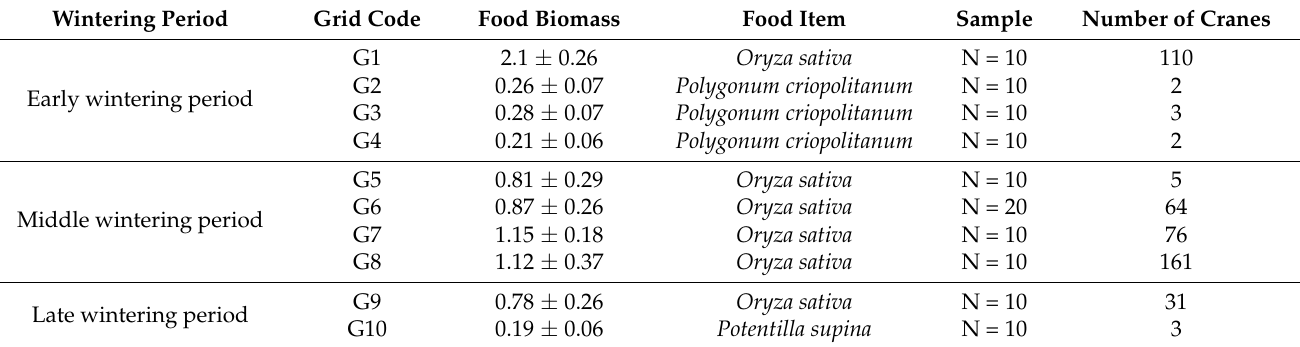
Table A2. The number of cranes, food biomass and item in the grids at Caizi Lakes (The food item was the main food resources for